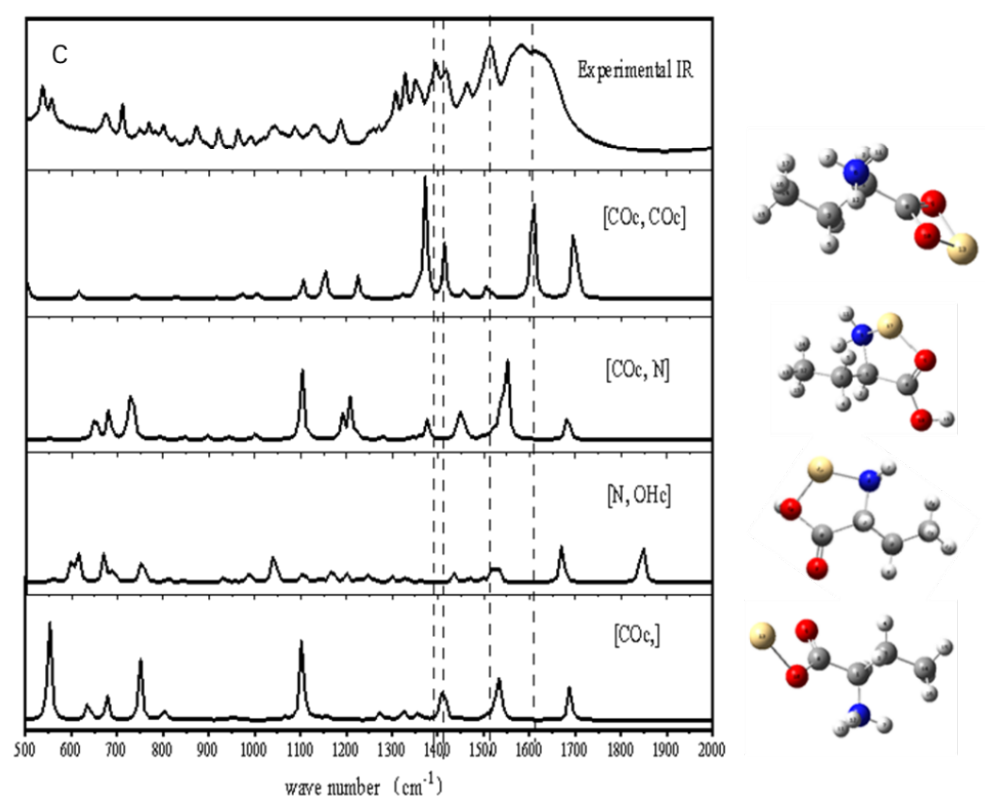
Figure 1. The experimental (upper) and calculated (lower) IR spectra of ( a ) GlyCd 2+ , ( b ) Ala Cd 2+ , and ( c ) Leu Cd 2+ . The gray, red, yellow, blue, and silver balls represent carbon, oxygen, cadmium, nitrogen, and hydrogen atoms, respectively.